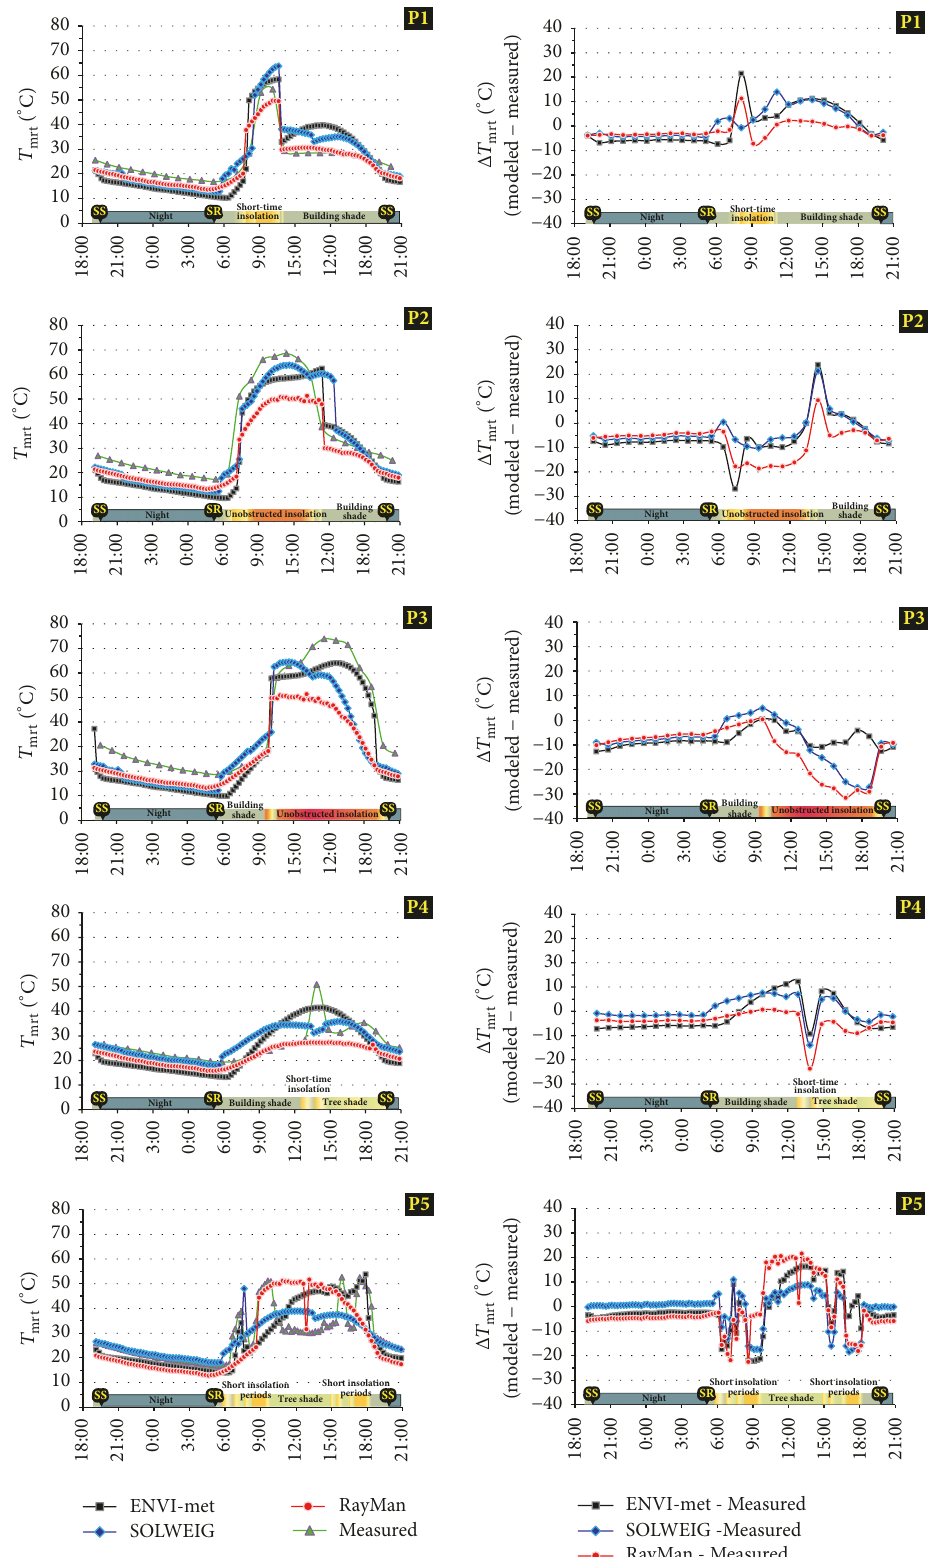
Figure 8: Deviation of the modeled 𝑇 mrt values from the measurement-based 𝑇 mrt at the five points during the survey period (SS: sunset, SR: sunrise; note: data are calculated from 15-minute averages). Horizontal bars at the bottom of each graph indicate when the measurement point became shaded or exposed to the sun as follows: (i) yellow and orange colors mark shorter and longer periods of solar exposure, respectively; (ii) light green indicates period of shade from trees; (iii) dark green suggests shade from buildings; (iv) dark gray signals nighttime with no short-wave radiation. SS and SR marks indicate times of sunset and sunrise,